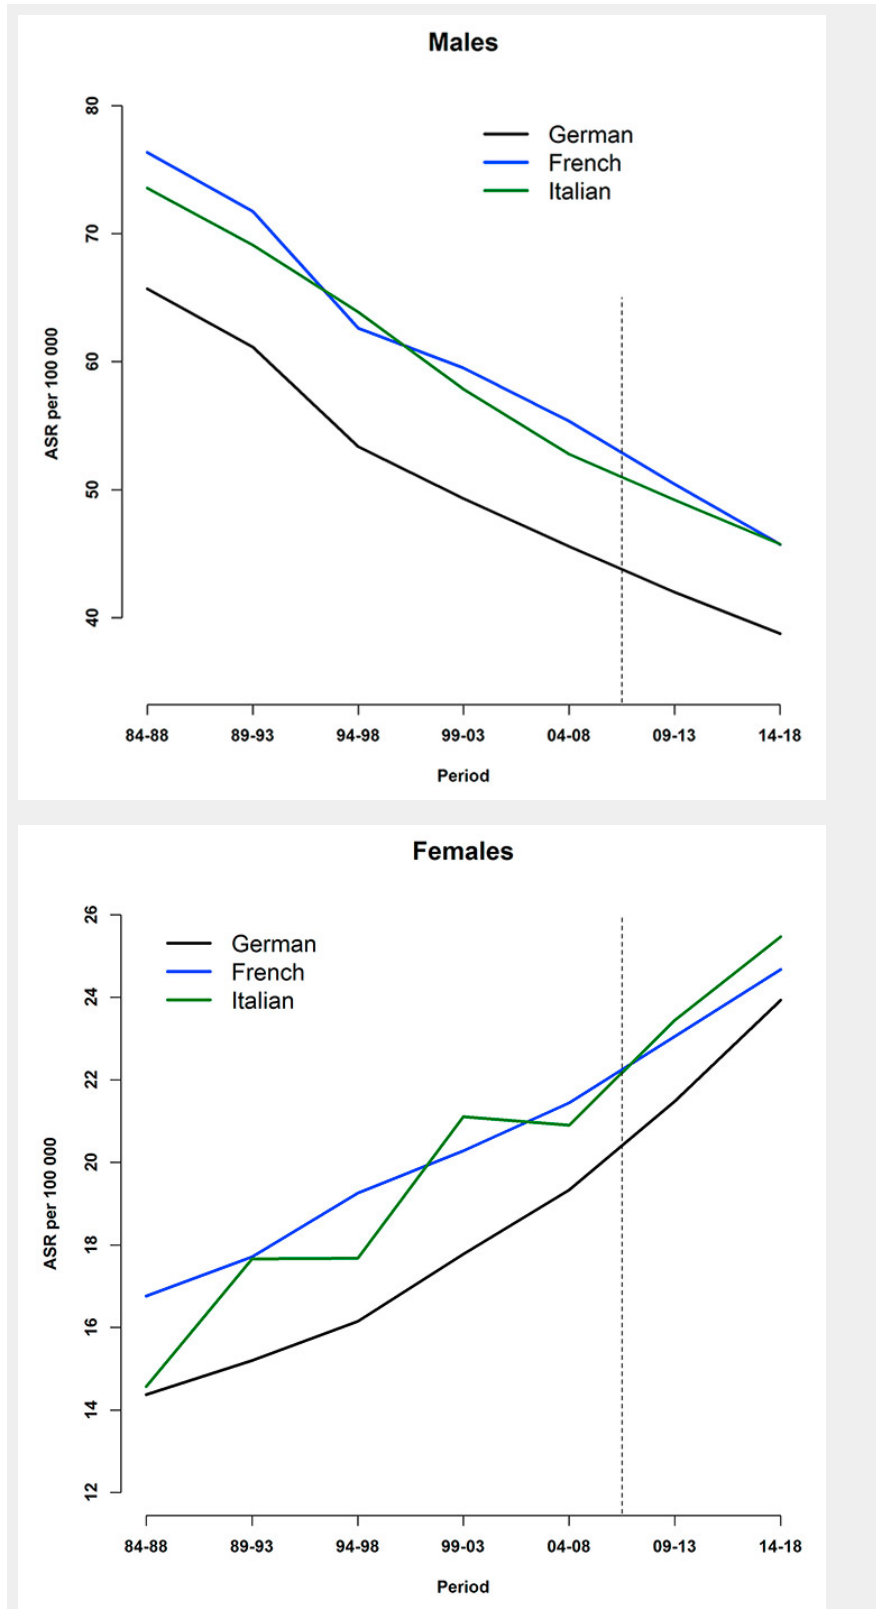
Figure 5 Language-region‒specific age-standardised tobacco-related cancer mortality rates (per 100,000), observed (during 1984–2008) and predicted (posterior median during 2009–2013 and 2014–2018) for (a) males and (b) females. The vertical line indicates the start of the prediction